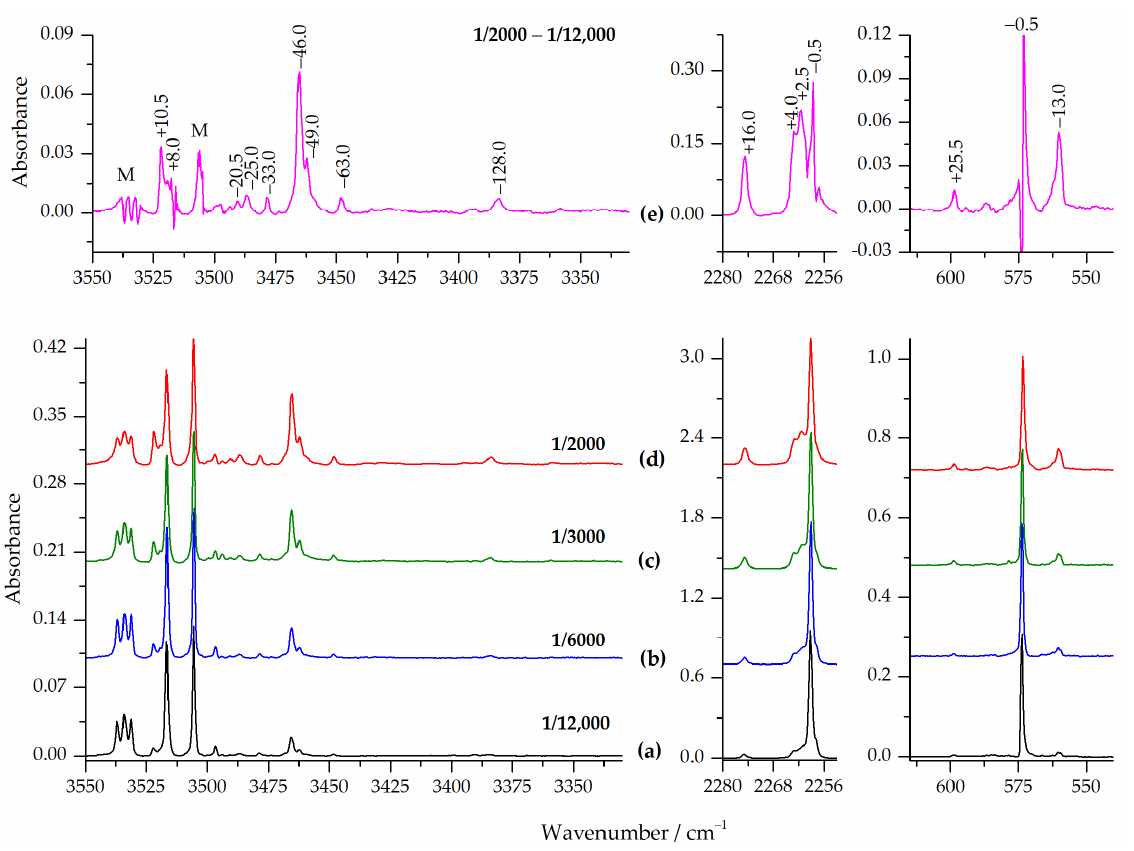
Figure 3. Bottom panels: the ν NH, ν as NCO and δ NCO regions in the spectra of HNCO/Ar matrices with 1/12,000 ( a ), 1/6000 ( b ), 1/3000 ( c ) and 1/2000 ( d ) concentrations. Top panels: the difference spectrum obtained by subtracting the HNCO/Ar = 1/12,000 spectrum from the HNCO/Ar = 1/2000 spectrum ( e ). The numbers show the red (minus) and blue (plus) wavenumber shifts compared to the HNCO monomer values. Letter M denotes HNCO monomer bands.